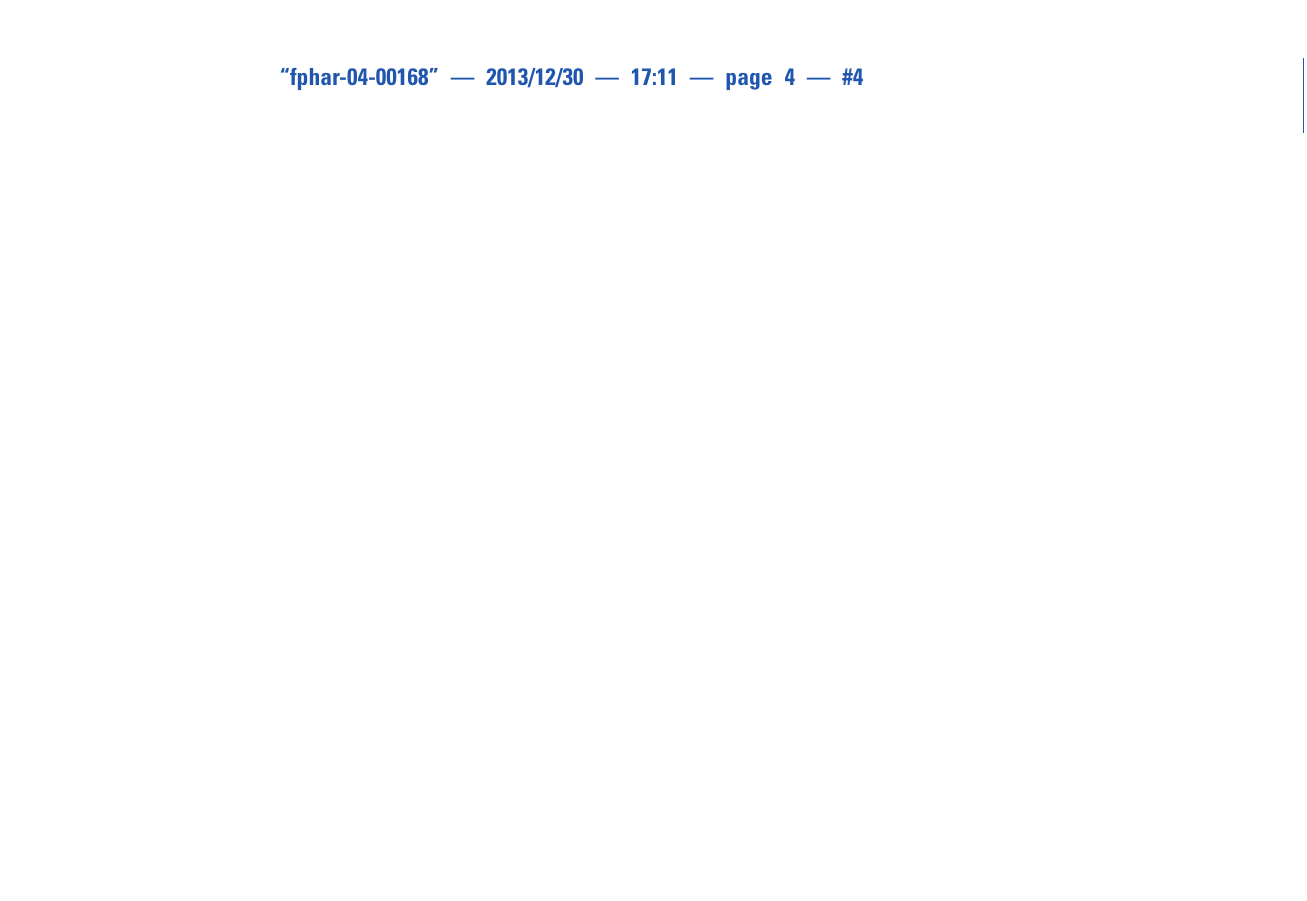
Table 1 | Relative expression of E. coli genes after adaptation to increasing concentration of tetracycline (Viveiros etal., 2007). @Tet MIC ( μ g/ml) soxS